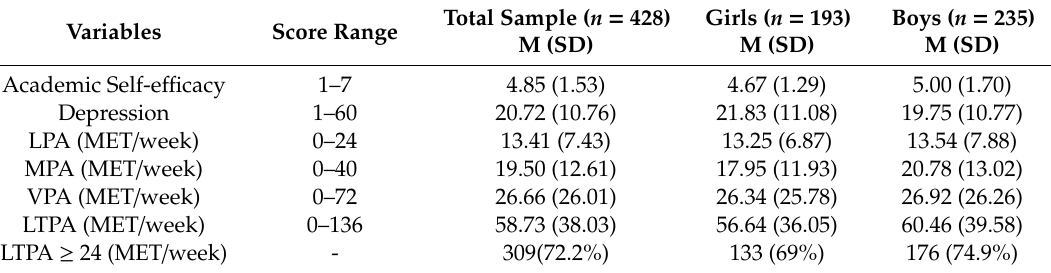
Table 1. The descriptive statistics of study variables ( n =